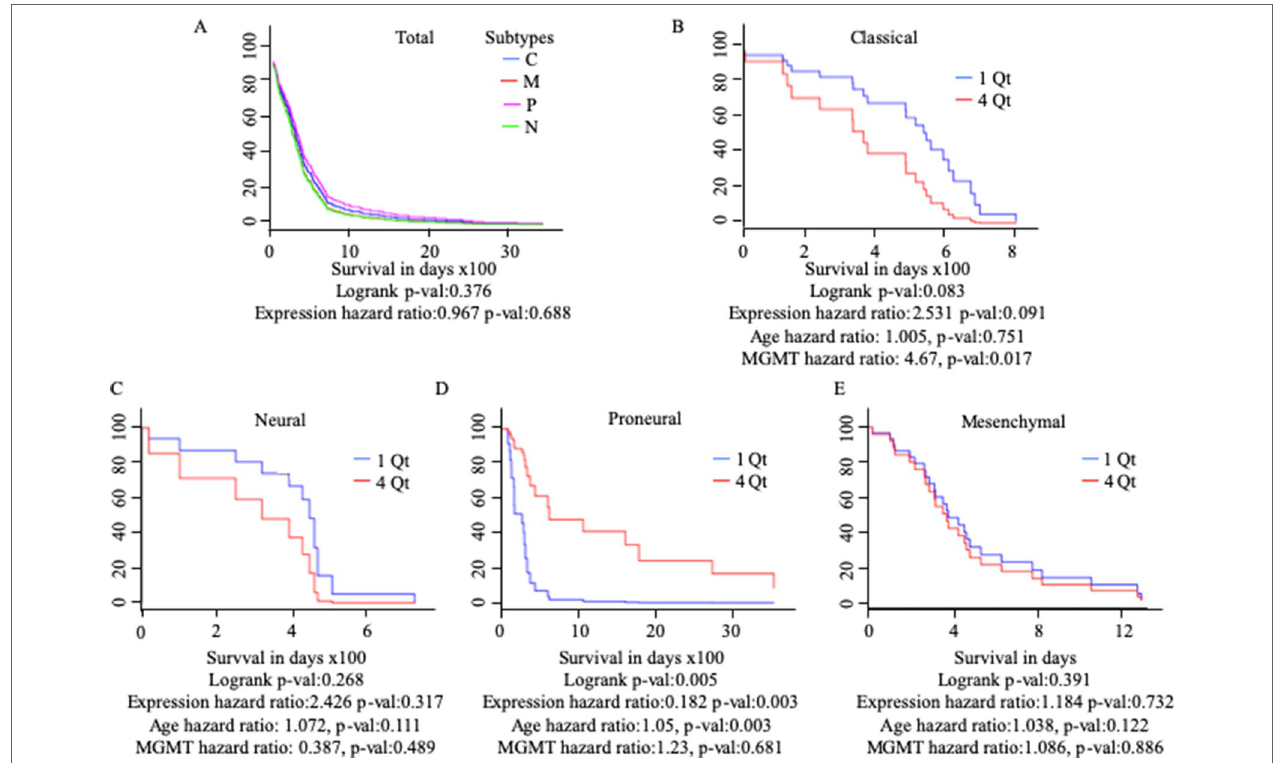
FIGURE 3 | Cox proportional analysis of 422 patients with GBM from the TCGA database divided into subtypes based on MuD expression level, as analyzed with GBM Bio Discovery Portal for total GBM (A) , Classical subtype (B) , Neural subtype (C) , Proneural subtype (D) and Mesenchymal subtype (E) . Patients were ranked into four quartiles based on MuD expression level. The survival rate of the patients from the first quartile with the lowest ranked MuD expression was compared to that of the patients from the fourth quartile. Age and MGMT promoter methylation status were used as covariates. C, classical; M, mesenchymal; P, proneural; N, neural; QT,